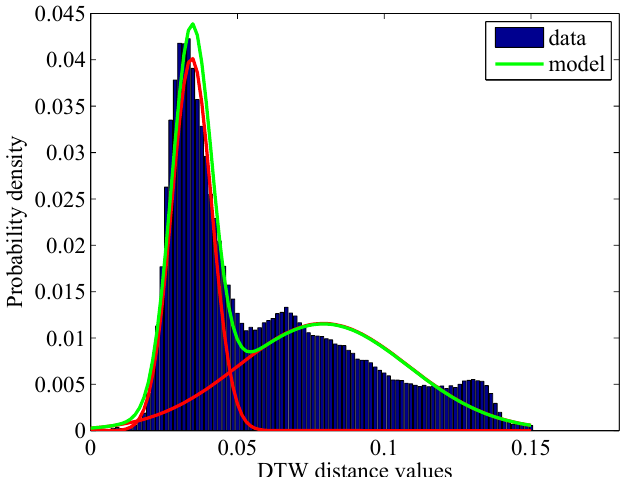
Figure 3. Histogram over DTW similarity scores and a mixture of two Gaussian distributions fitted to these